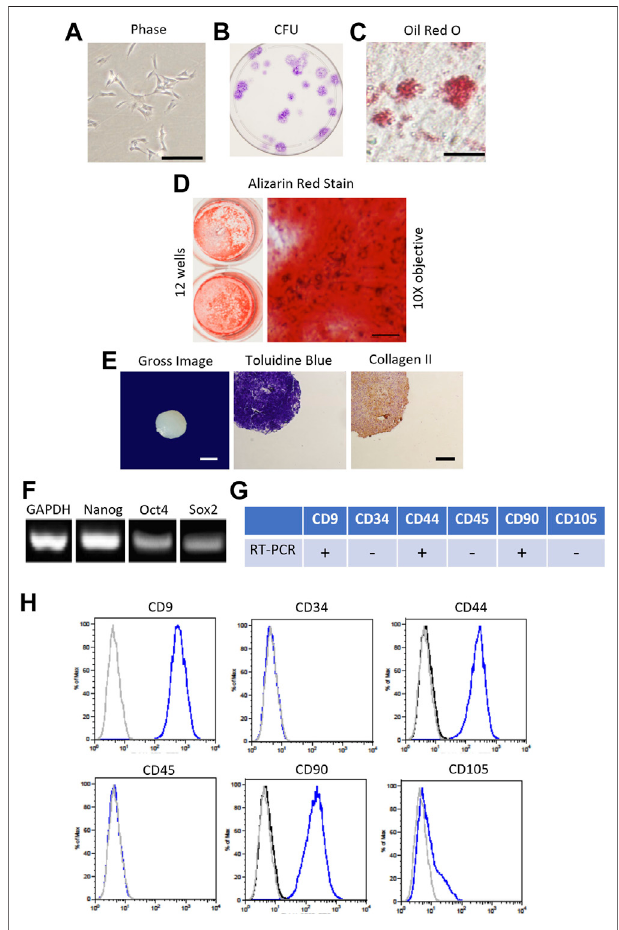
FIGURE 1 | Characterization of canine bone marrow-derived mesenchymal stromal cell (cMSC). (A) : Passage 1 cMSCs were expanded at 100 cells/cm 2 in CCM with media exchange every 48 h until cMSCs reached 70 – 80% Representative phase contrast microscopy image of cMSCs exhibiting a spindle-shaped, mesenchymal phenotype (bar (cid:2) 250 µm). (B) : cMSCs were assessed with the classic colony forming unit (CFU) assay to demonstrate ability to form distinct colonies in the absence of media exchange overa21 daystimecourse. (C) :Adipogenicdifferentiationwascon fi rmed via Oil Red O stainingafter 21 daysofculture inadipogenicdifferentiation medium (bar (cid:2) 25 µm). (D) : Osteogenic differentiation was con fi rmed via Alizarin Red Stain after 21 days of culture in osteogenic differentiation medium (ODM) supplemented with + 200 ng/ml of rh-BMP-2. Gross photography of representative wells are provided (left) in conjunction with transmitted light microscopy images(right, bar (cid:2) 125 µm). (E) : Chondrogenic differentiation was con fi rmed using the traditional micromass assay. Gross image of a representative cMSCchondrogenic spheroid (bar (cid:2) 300 µm) isprovided on